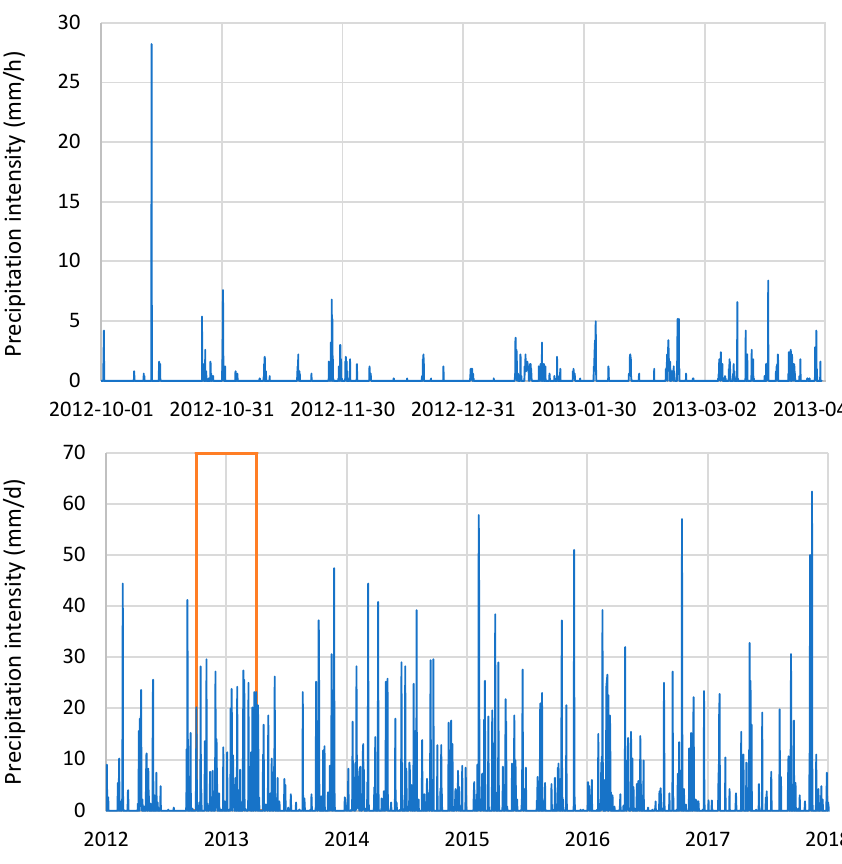
Figure 3. Evolution of precipitation in Bologna, as a weather element, seen at ( upper ) hourly time scale for six months and ( lower ) daily time scale for six years (the orange rectangle is the time domain of the upper graph).